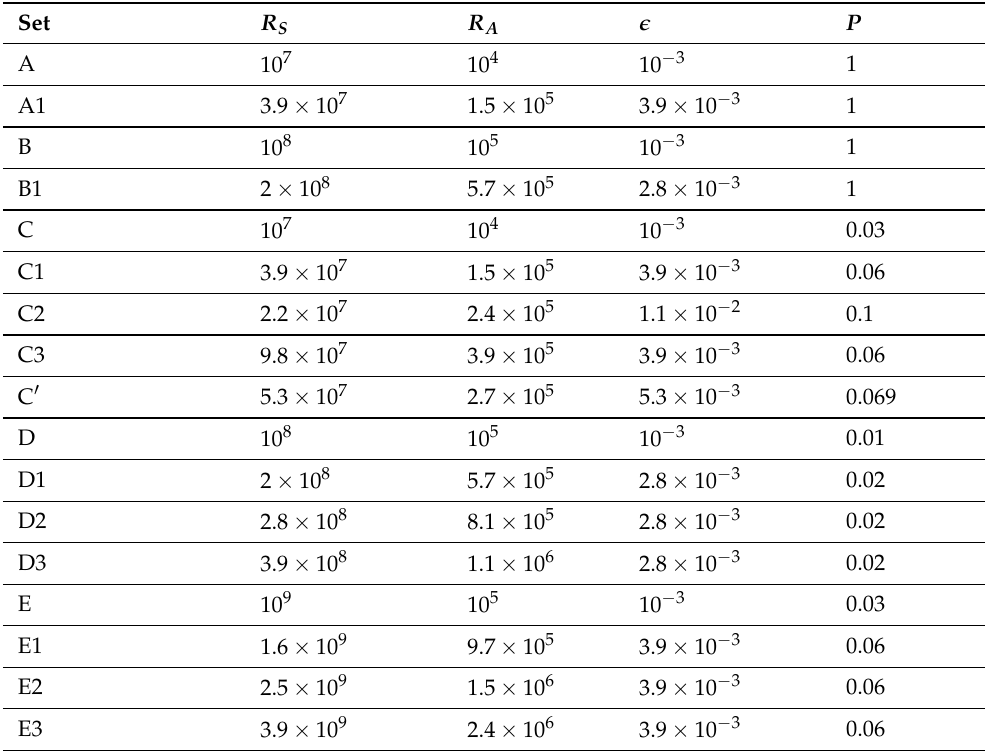
Table 2. Sets of dimensionless parameters used in the